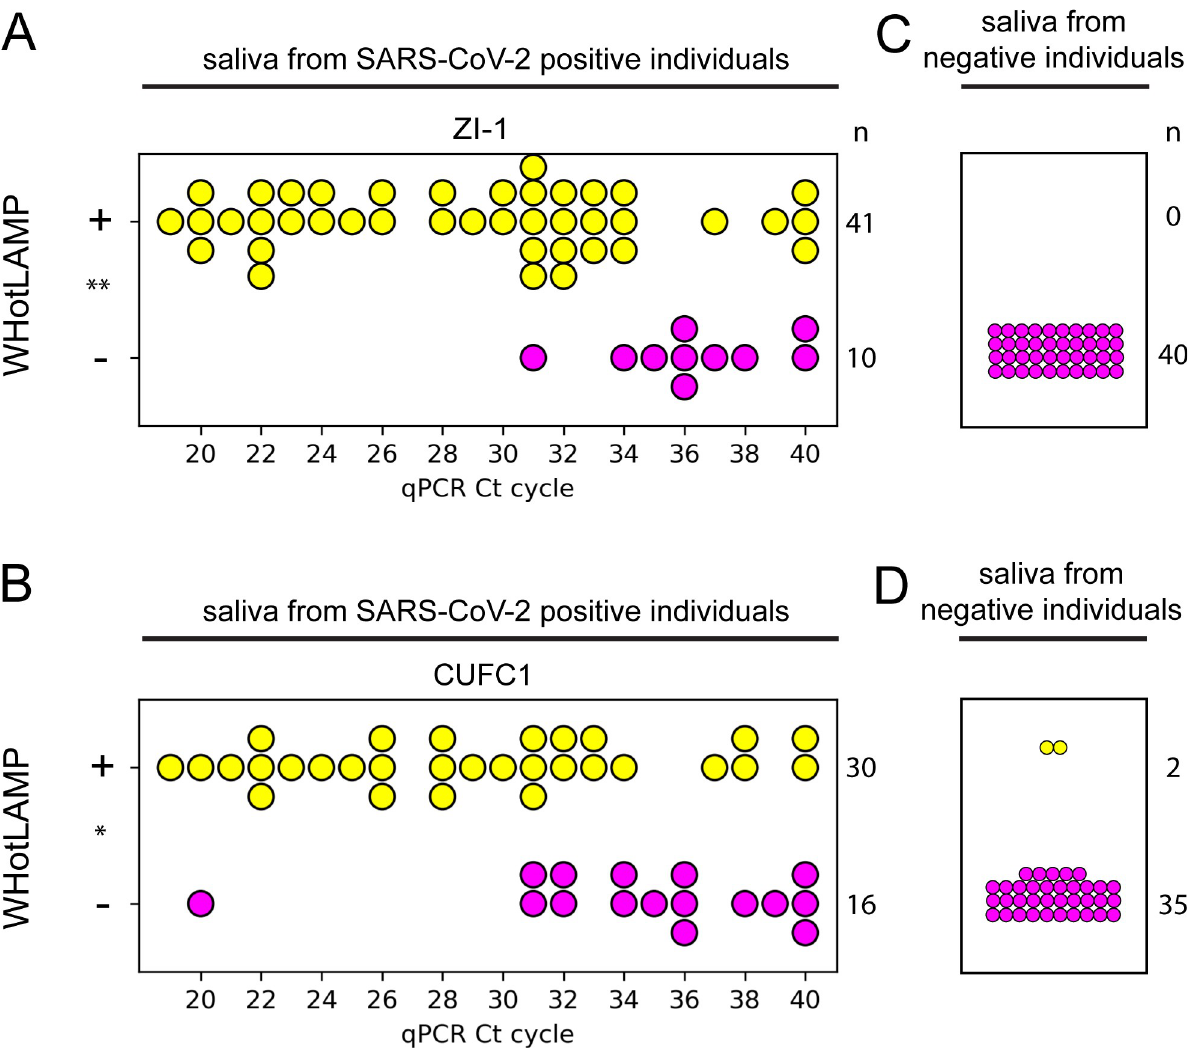
Fig 6. Sensitivity and specificity of WHotLAMP. A , B Sensitivity and C , D specificity of WHotLAMP using ( A , C ) ZI-1 or ( B , D ) CUFC1 primers with qPCR SARS-CoV-2 positive saliva. Yellow circles denote positive (+) LAMP reactions and magenta circles denote negative (-) LAMP reactions. �� P < 0.001 and � P < 0.01 between WHotLAMP positive and negative samples, by t